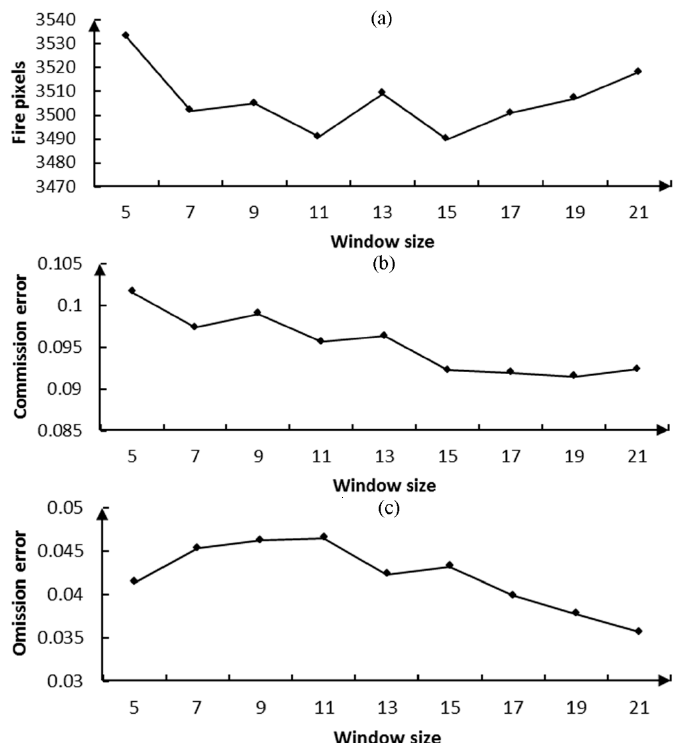
Figure 15. Fire detection results of the image acquired on 29 April with different STM window sizes: ( a ) number of fire pixels; ( b ) commission error; and ( c ) omission error.